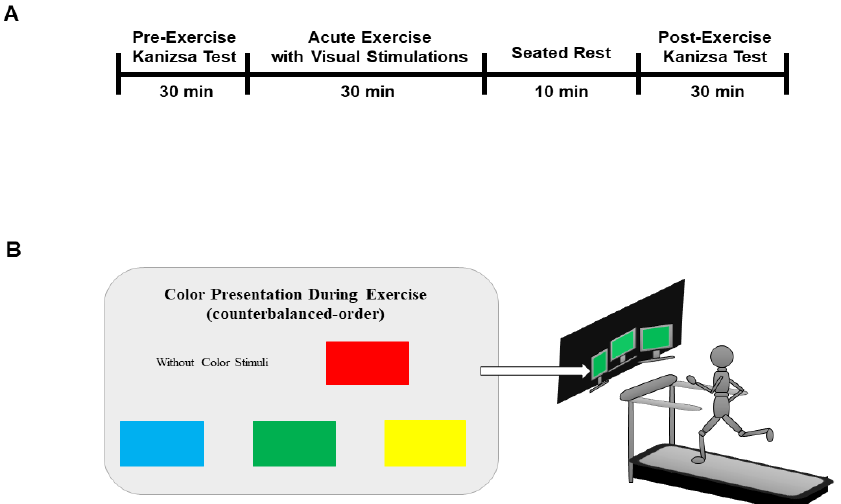
Figure 1. The experimental design of this study: ( A ) After performing the pre-exercise Kanizsa test, participants underwent a 30-min exercise with a color stimulus that was followed by a 10-min seated cool-down. Upon completing the cool-down, participants performed the post-exercise Kanizsa test; ( B ) color stimuli were presented on a monitor screen (in a counterbalanced order across participants), situated 3 m in front and on both sides of the treadmill. To provide the same environment providing the stimuli, the wall behind the monitors was covered with black cloth and the light was off.